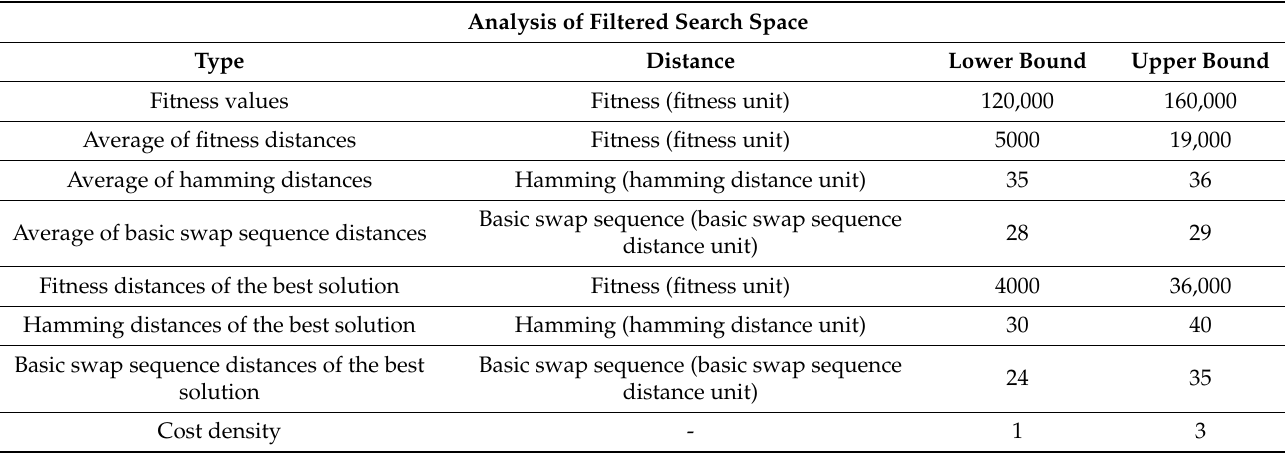
Table 2. Analysis of the scattered filtered search space: